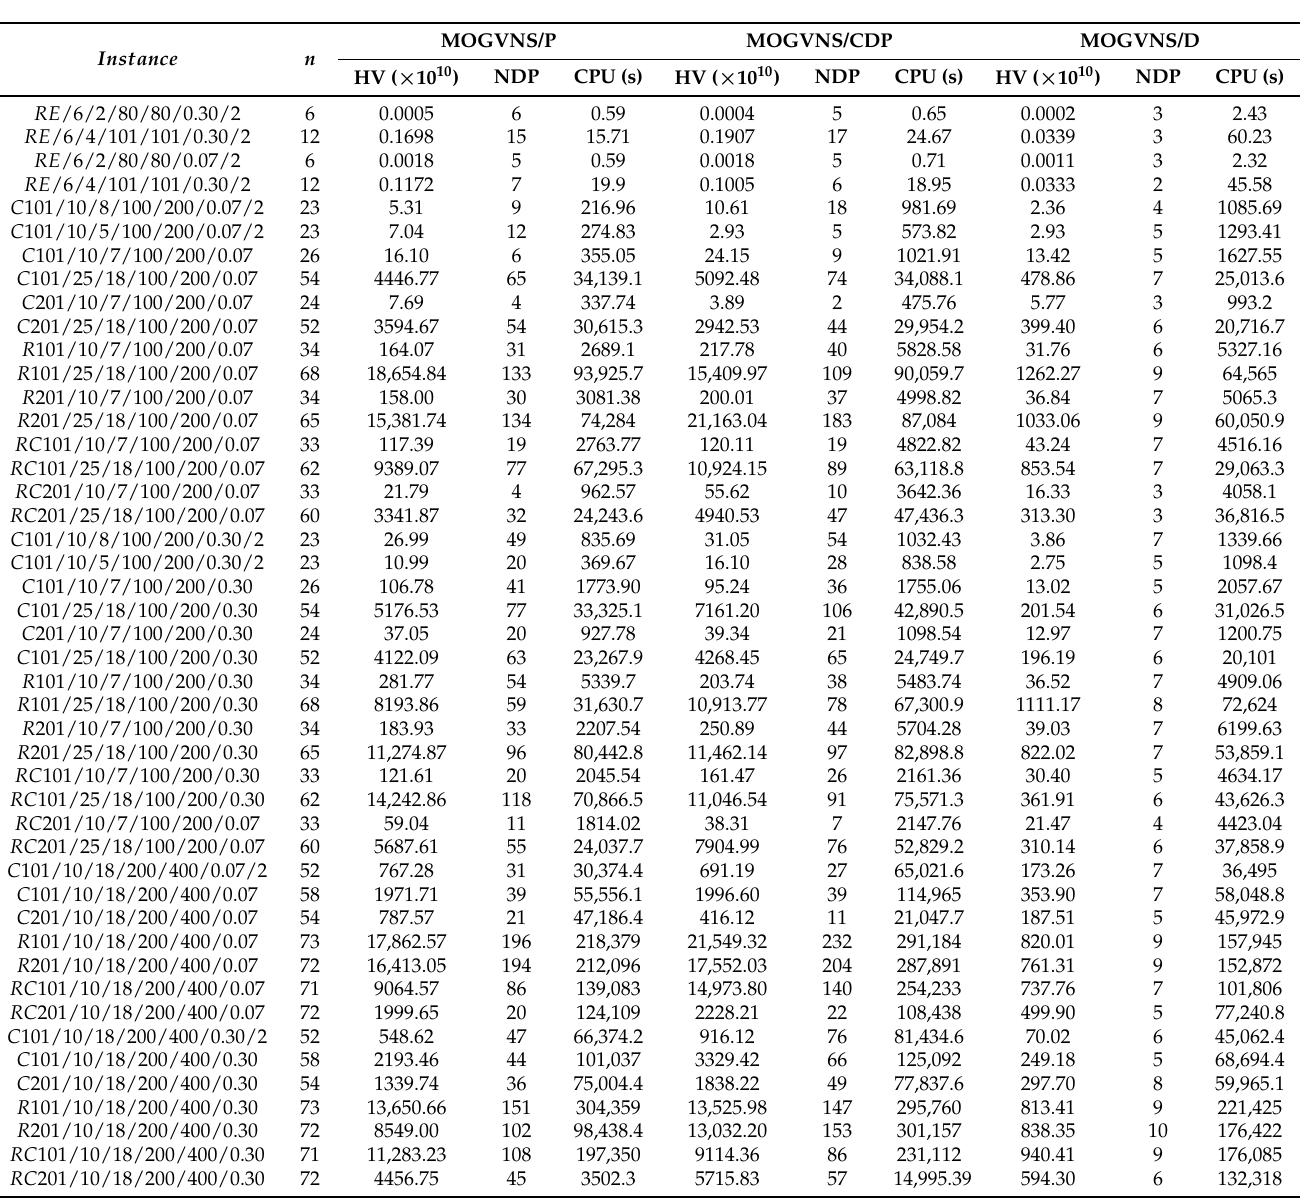
Table A5. Results of MOGVNS/P, MOGVNS/CDP and MOGVNS/D for the failure cost as a second